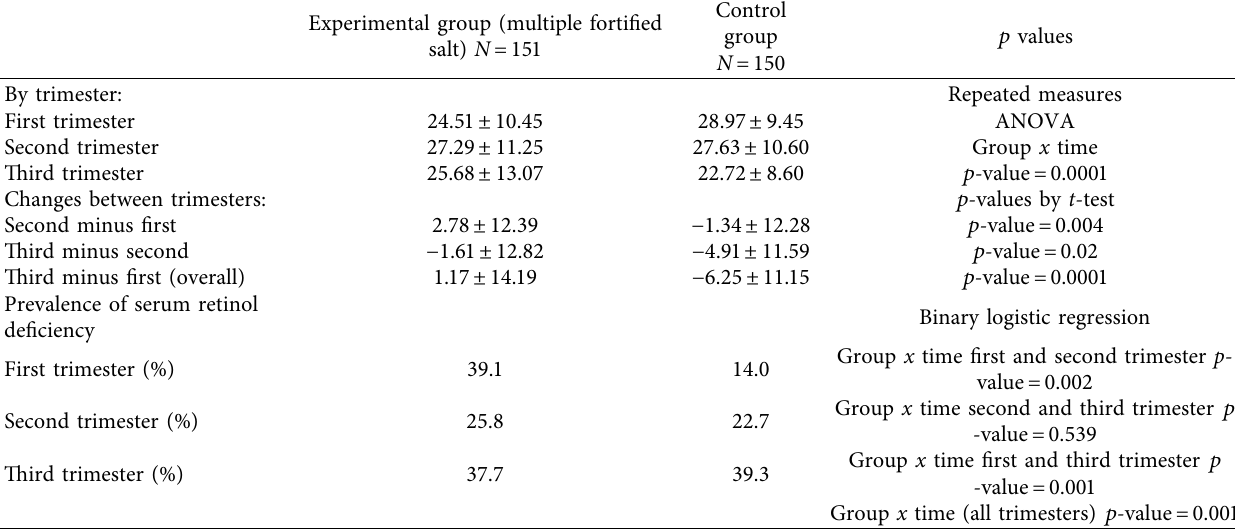
Table 4: Serum retinol § , change in serum retinol, and serum retinol defciency ∗ in the three trimesters. Experimental group (multiple fortifed